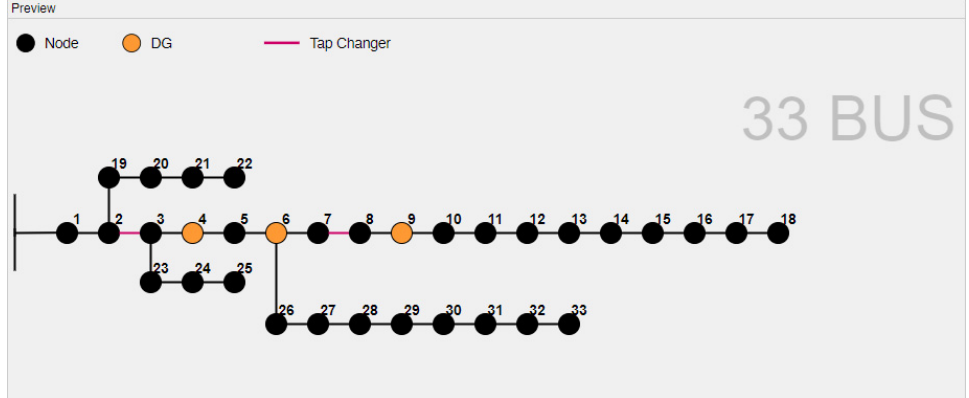
Figure 5. Preview panel of the toolbox.